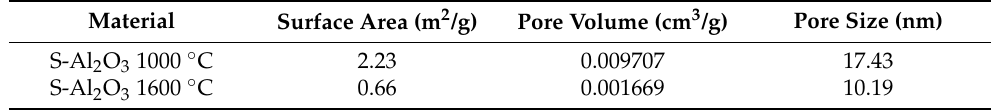
Table 2. Textural properties of alumina spheres treated at 1000 and 1600 ◦